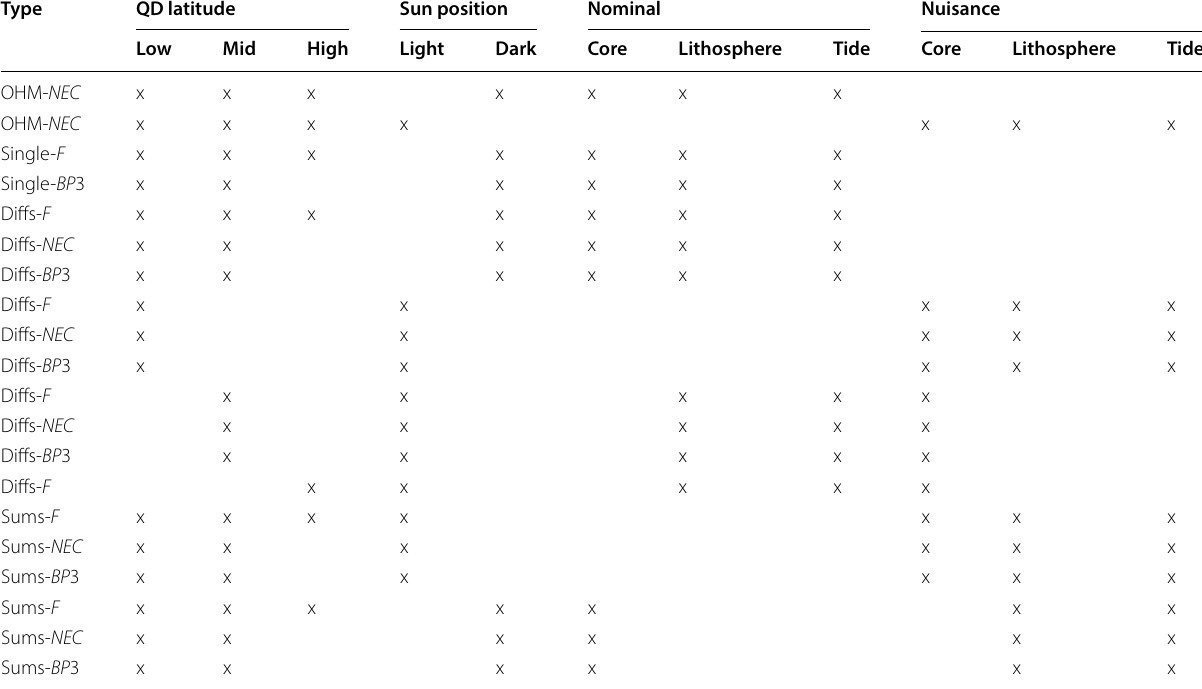
Table 2 CM6 SIVW application, where the “x” indicates the Quasi-Dipole (QD) latitude and sun position of the data type and which parameters it directly influences, and where “OHM” denotes observatory measurements, “Single”, “Diffs” and “Sums” denote single, differenced and summed measurements, respectively, “ NEC ” and “ BP 3” denote the local North-East-Center and HB-theory frame for vector data, respectively, and “ F ” denotes